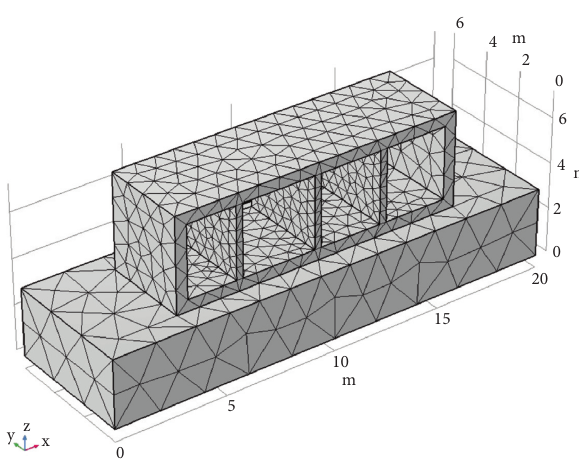
Figure 6: Numerical modelling.